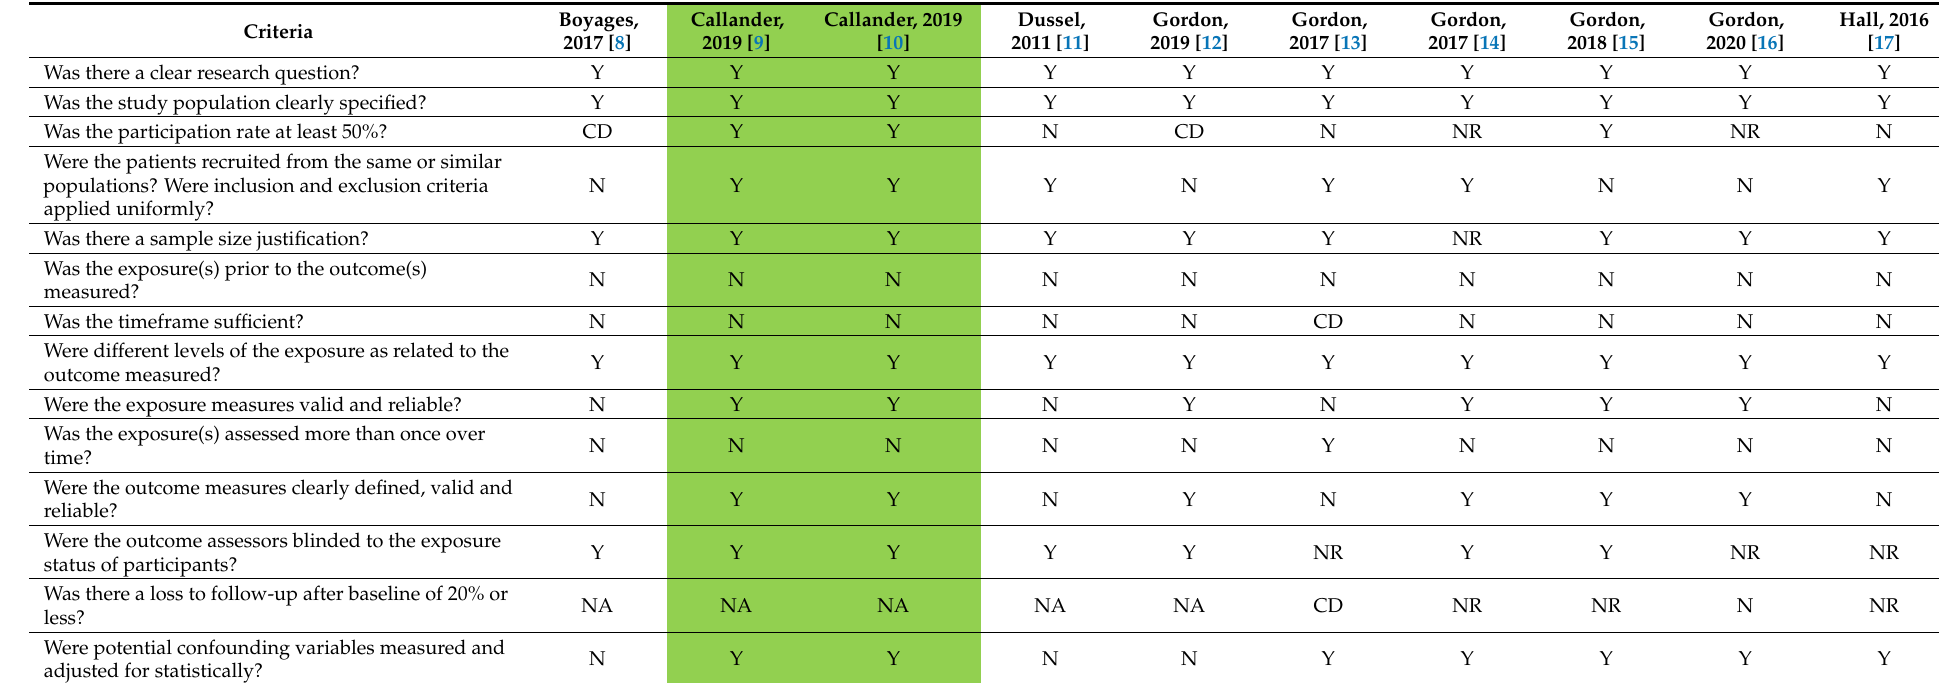
Table 2. Quality assessment of